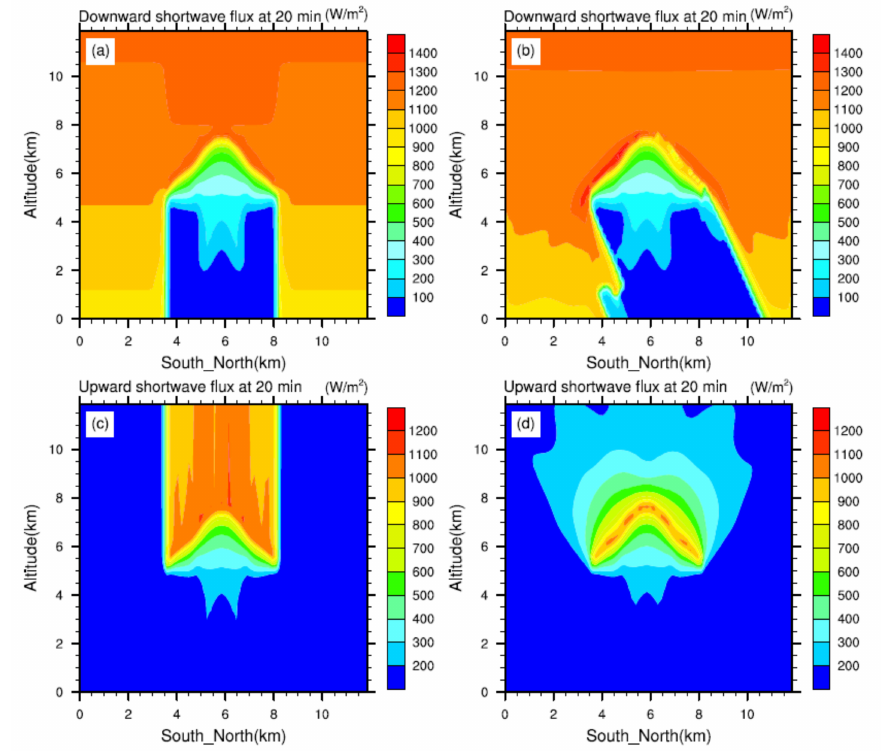
Figure 8. Downward and Upward shortwave radiation flux in the 1D radiation case ( a , c ) and the 3D radiation case ( b , d